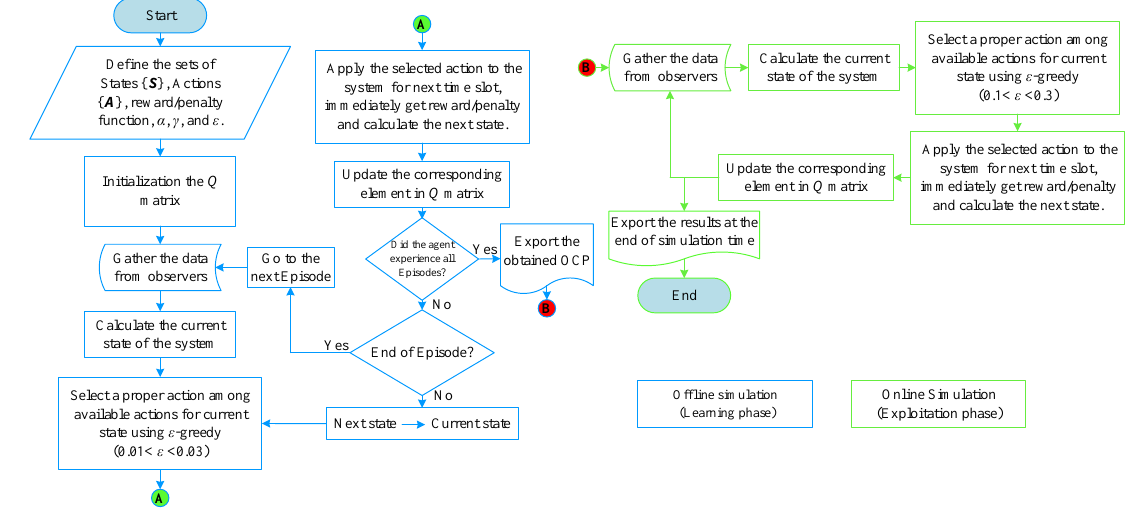
Figure 4. The flowchart of the proposed Q -learning control